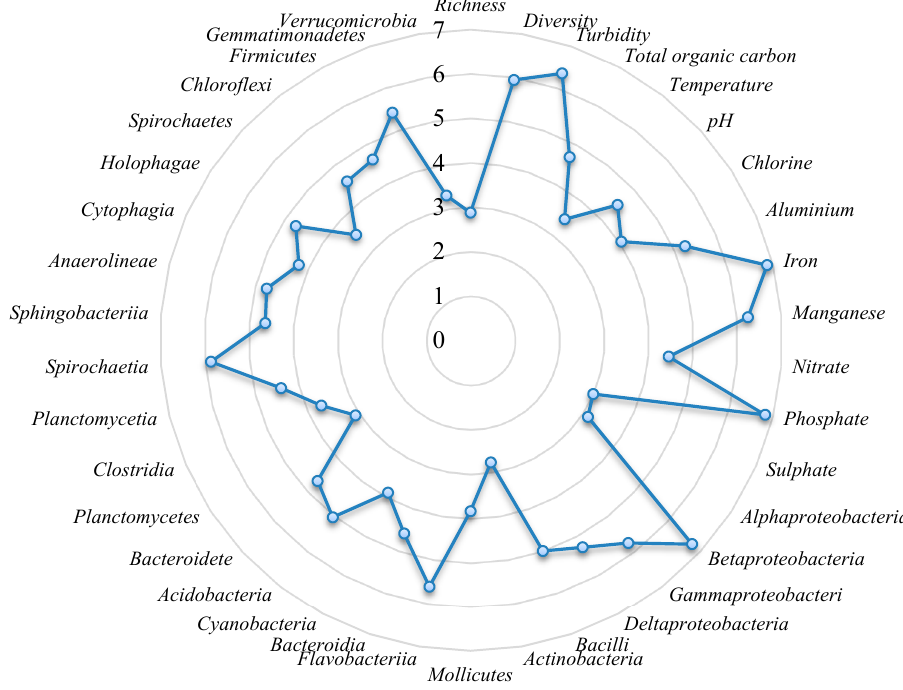
Figure 2. Prominence values for all the considered factors .